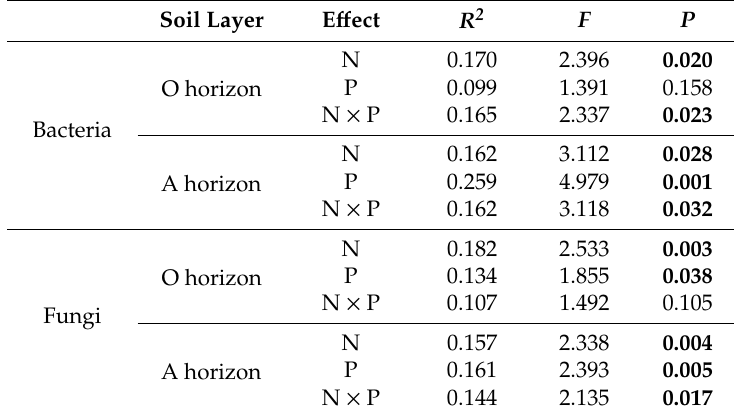
Figure 2. Non-metric multidimensional scaling (NMDS) plots of bacterial ( a , c ) and fungal ( b , d ) community compositions under N and P additions. OC, ON, OP and ONP indicate the O horizon soils (0–5 cm, ( a , b )) under control (C, without N and P addition), N addition, P addition and NP addition, respectively. AC, AN, AP and ANP indicate the A horizon soils (5–15 cm, ( c , d )) under control (C, without N and P addition), N addition, P addition and NP addition, respectively. Table 2. Two-way PERMANOVA analysis (permutations = 999) estimated the effects of nitrogen addition (N), phosphorus addition (P) and N × P interaction on the soil microbial community structure. p values in bold indicate significant effects.